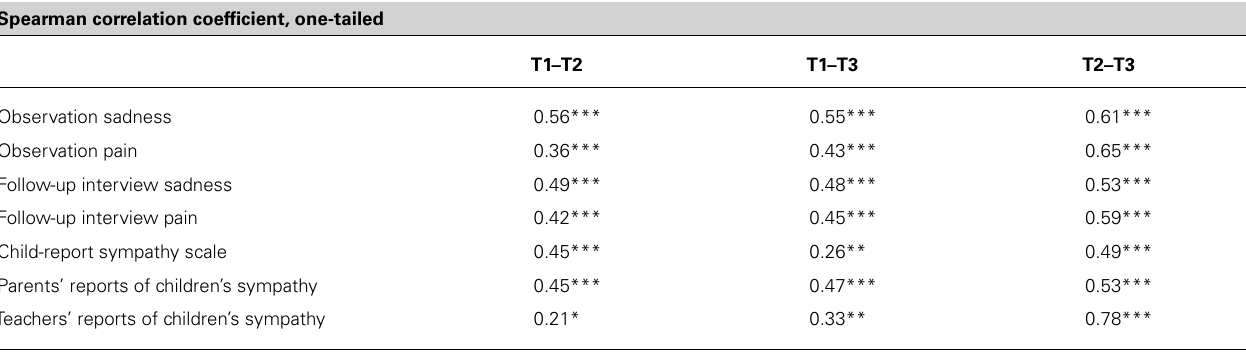
Table 5 | Rank-order stability of methods measuring sympathy.